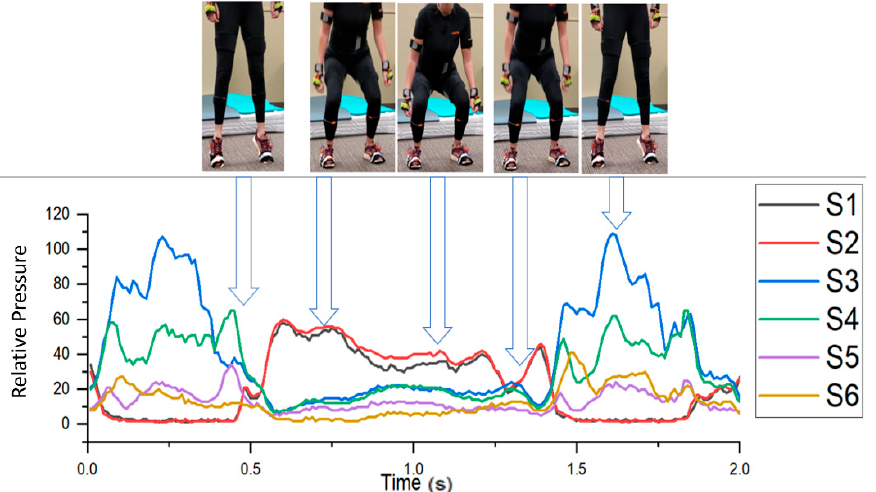
Figure 5. The squat motion with the accompanying sensor readout.